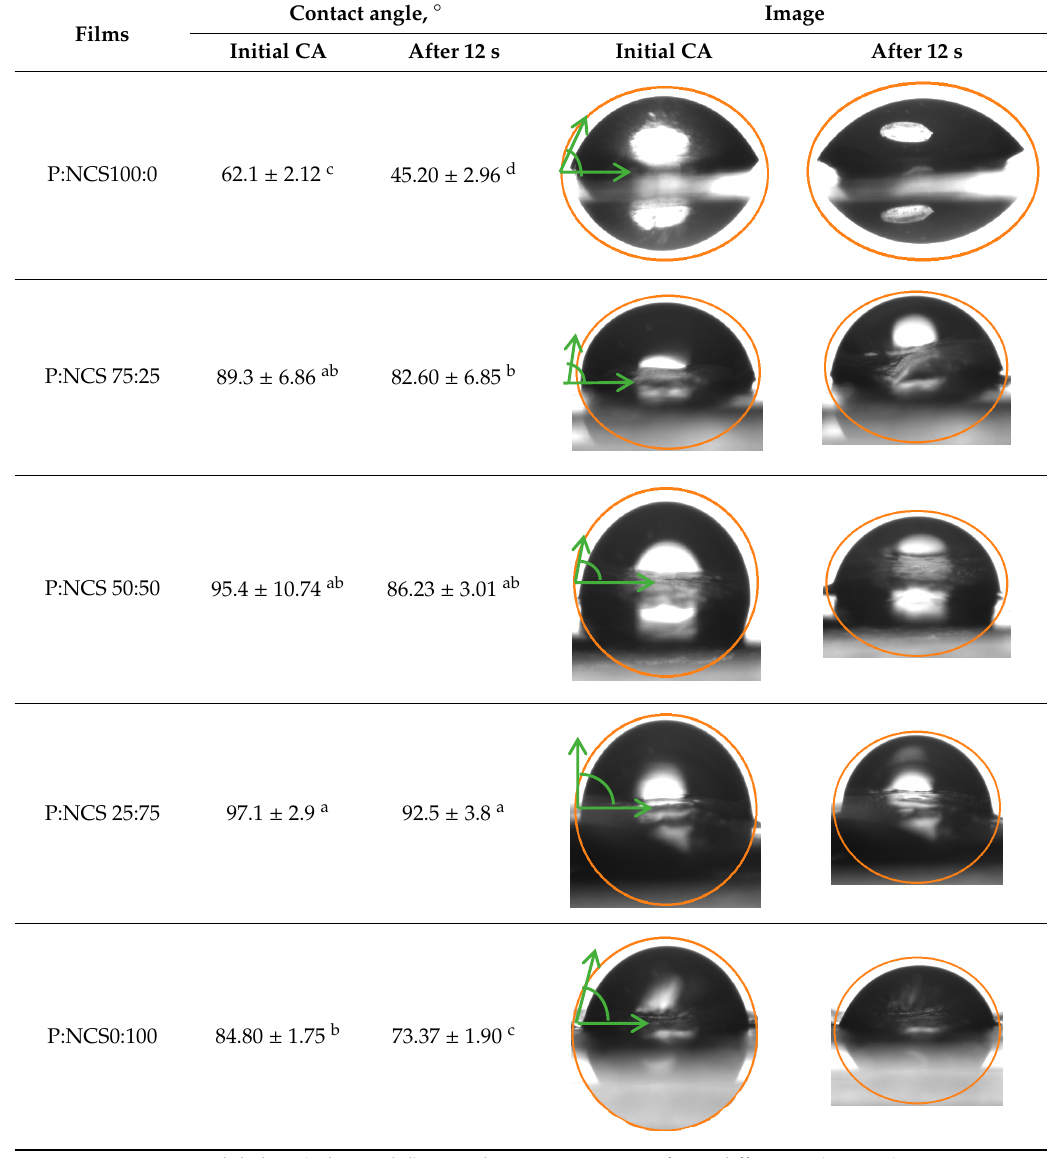
Table 2. The contact angle of films.